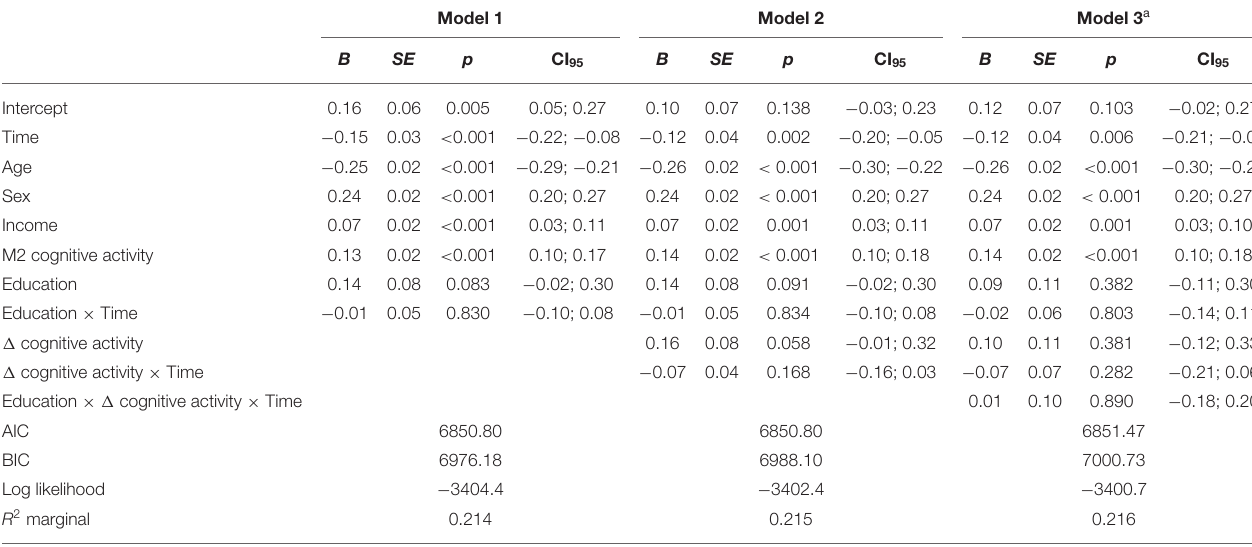
TABLE 3 | Effects of change in cognitive activity and education on change in episodic memory (EM) with